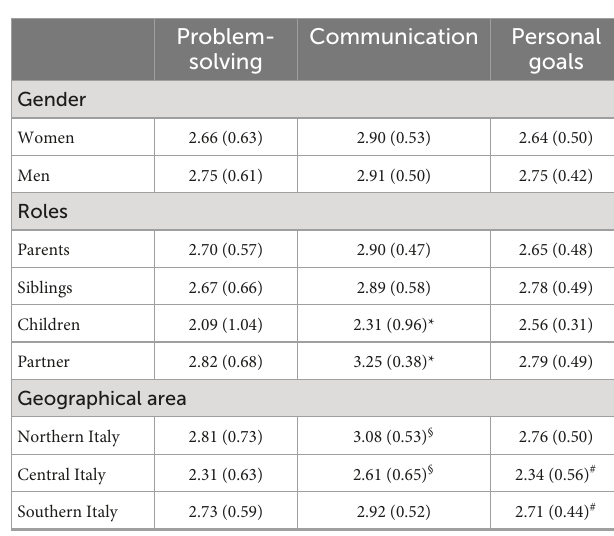
TABLE 2 Total mean scores at dimensions of the family functioning questionnaire (FFQ) according to gender, family roles, and location of caregivers (higher scores indicate better